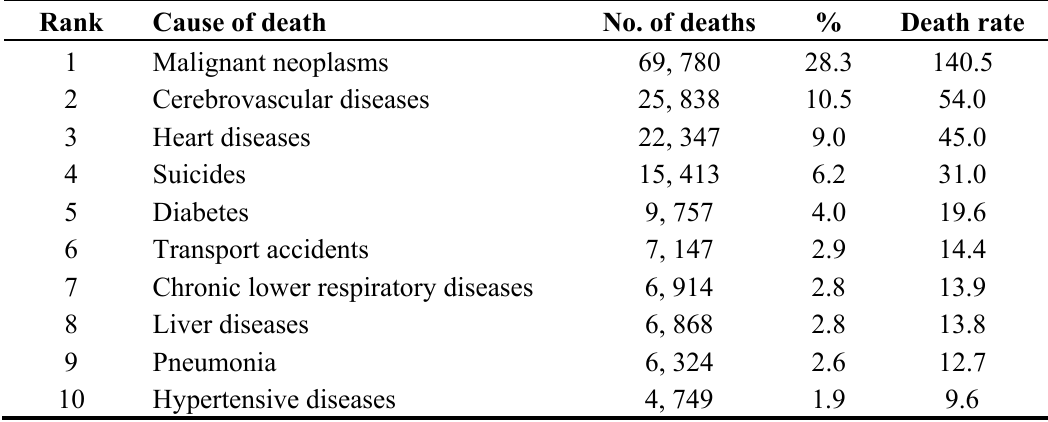
Table 1. The leading causes of deaths in South Korea